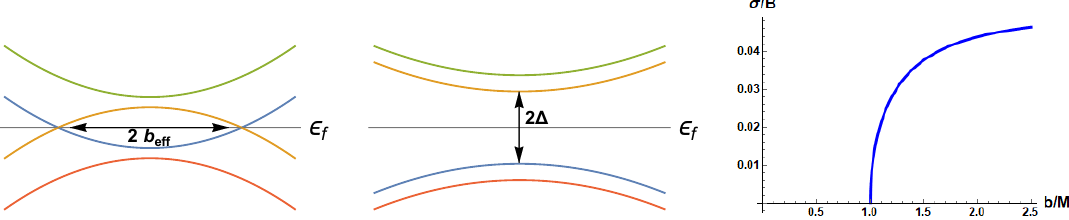
Figure 2 . Sketch of the Weyl semimetal quantum phase transition. Left: spectrum of the theory for b 2 > M 2 with the two Weyl nodes. Center: gapped spectrum of the theory for b 2 > M 2 . Right: anomalous Hall conductivity across the QPT from the EFT result eq.(1.2). (AHC) de(cid:12)ned as the Hall conductivity at zero magnetic